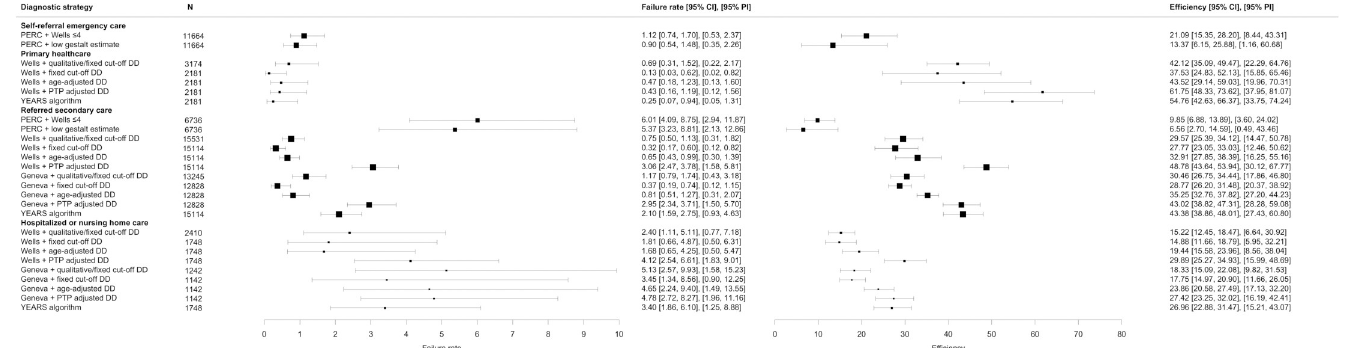
Fig 1. Forest plot of failure rate and efficiency of the diagnostic strategies across healthcare settings. CI, confidence interval; (C)PTP, (clinical) pretest probability; DD, D-dimer; N , number of patients; PERC, Pulmonary Embolism Rule-out Criteria; PI, prediction interval; PTP, pretest probability.